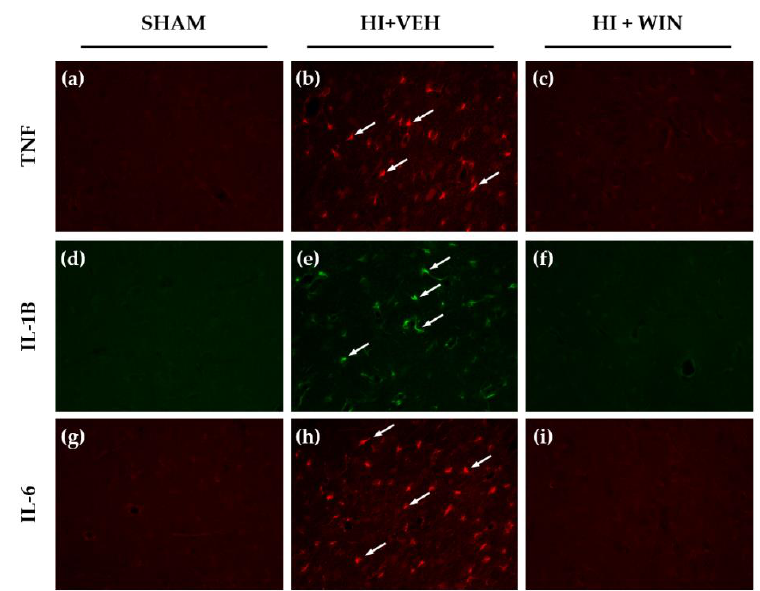
Figure 3. Representative microphotographs 3 h after HI TNF-α ( a , b , c ), IL-1β ( d , e , f ), and IL-6 ( g , h , i ) positive cells after immunofluorescence labeling. Cortex brain sections were obtained after sham operation ( a , d , g ), HI+vehicle ( b , e , h ) or HI+WIN treatment ( c , f , i ). The histological evaluation reveals the presence of these cytokines (arrows) in asphyctic animals. Original magnification: ×200.